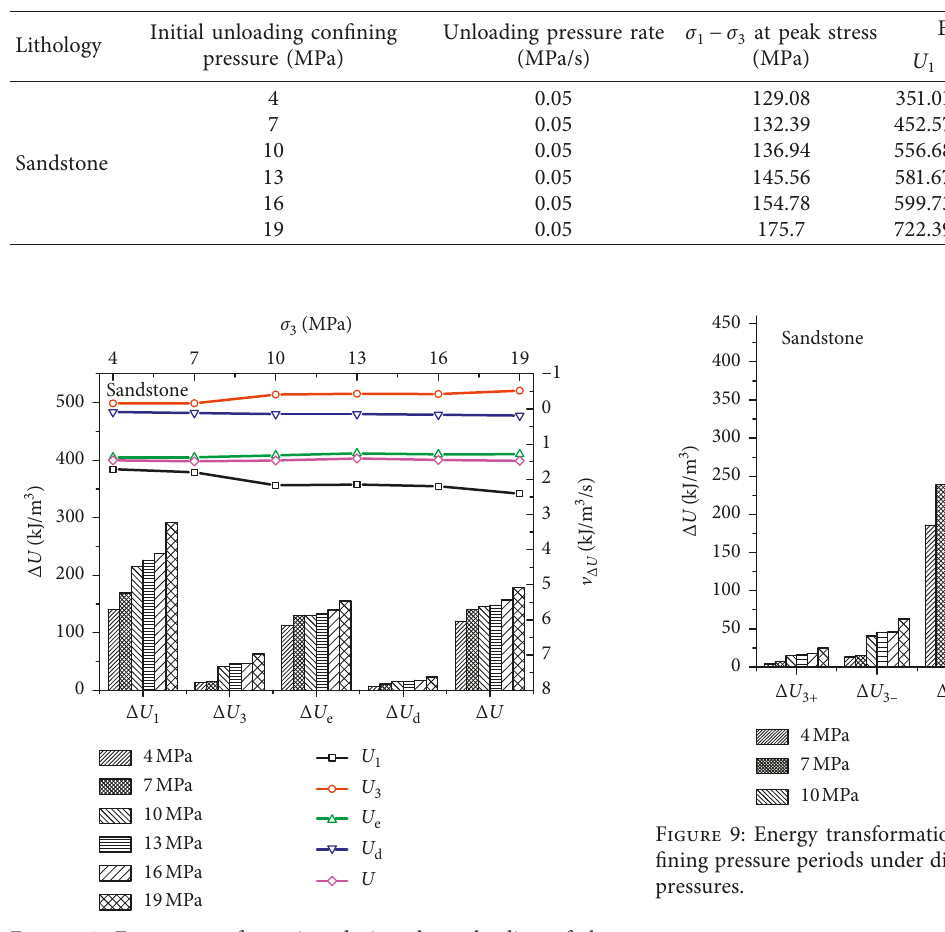
Figure 8: Energy transformation during the unloading of the confining pressure under different initial confining pressures.